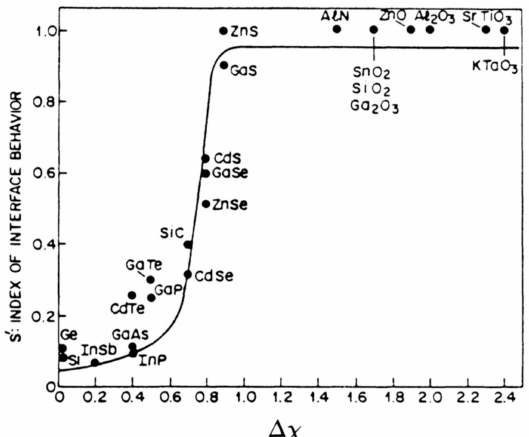
Figure 3. Collected data representing several independent experiments plotted as a function of lattice electronegativity di ff erence ∆ χ . Reprinted with permission from Kurtin et al, Phys Rev Lett., 22, 1433 (1969). Copyright (1969) by the American Physical